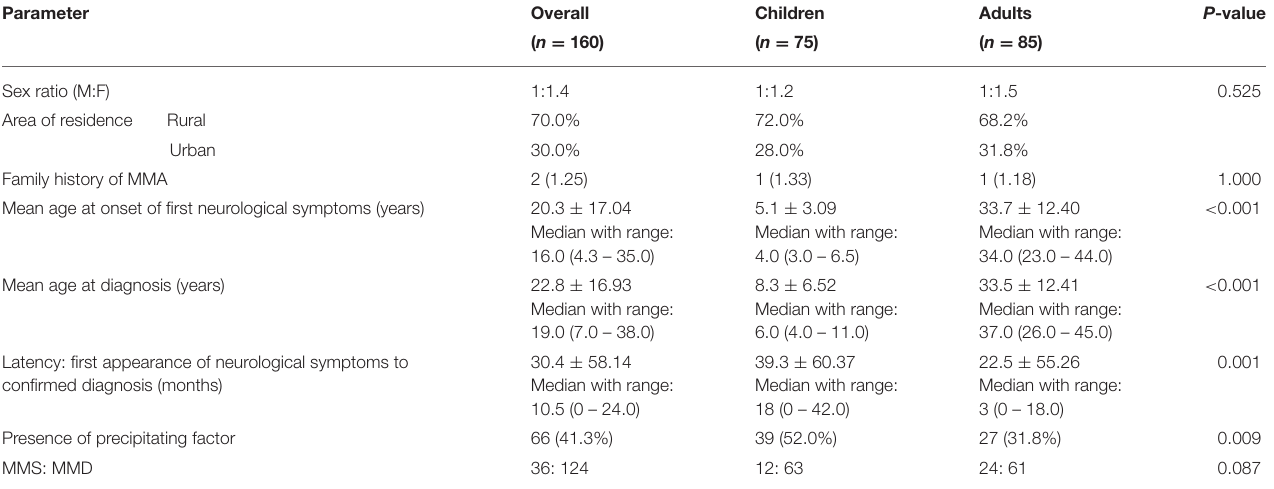
TABLE 1 | Clinico-demographic analysis of Moyamoya angiopathy (MMA) patients. Parameter